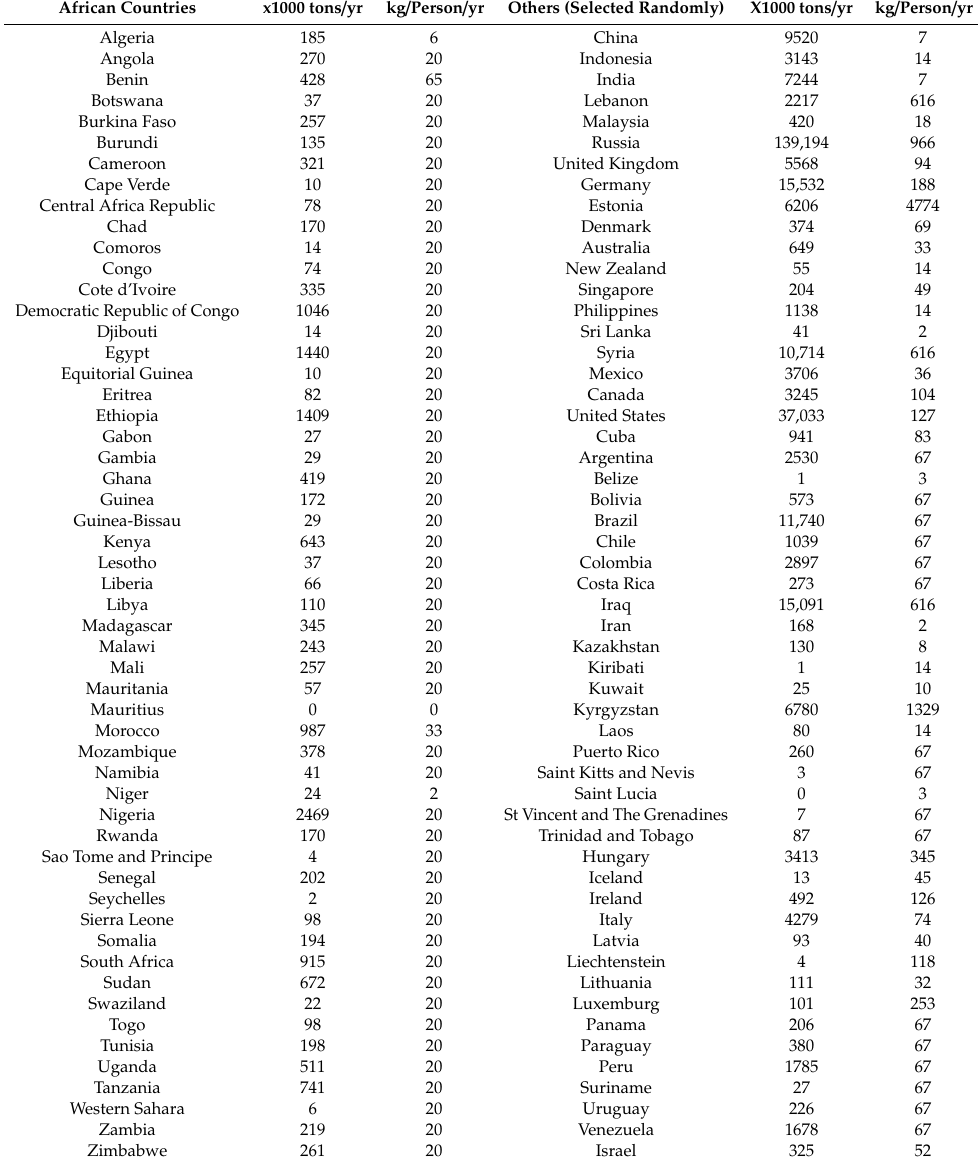
Table 1. Hazardous Waste by Country. Source: